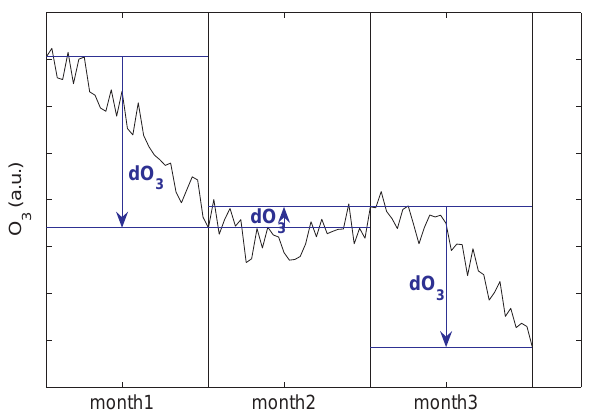
Fig. 7. Schematic illustrating monthly ozone tendencies. An arbitrary ozone time series (with arbitrary units) is shown for three months. The difference between the ozone value at the beginning and the end of the months (blue horizontal lines) is the same as the accumulated change in ozone over the course of each month (blue arrows).